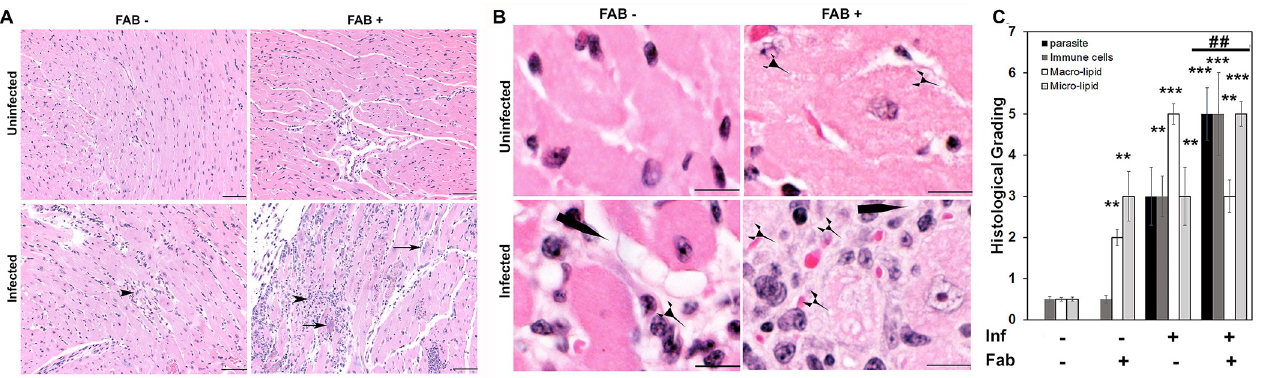
Fig 1. Fat ablation increases cardiac parasite load, lipid accumulation and cardiac pathology in T . cruzi infected acute (30 DPI) CD murine model (n = 6; minimum 5 images/section were analyzed). A. Hematoxylin and eosin (H&E) staining of hearts in indicated mice (infected or uninfected mice, fat-ablated (Fab +) or fat-unablated (Fab-). Infiltrated immune cells, black arrowhead; amastigote nests, black long arrow, and presence of lipid granules (see S2 Fig). Bar = 100 μ m, 20x magnification. Additional images are presented as S3 Fig. B. Magnified (40x) images of H&E stained heart sections of indicated mice showing macro-vesicular (black long pointer) and micro-vesicular (black short pointer) lipid droplets. Bar = 50 um. C. Histologic grading of heart tissue pathology was carried out according to experimental groups and classified in terms of degree of parasite load, infiltrated immune cells, size of lipid droplets (macro lipid ( � 20um) and micro lipid ( � 20um) droplets) in the H&E sections of hearts in acute T . cruzi infected mice with and without fat ablation. The values plotted are mean ± standard deviation (SD) from n = 5. �� , p < 0.01 ��� , p <